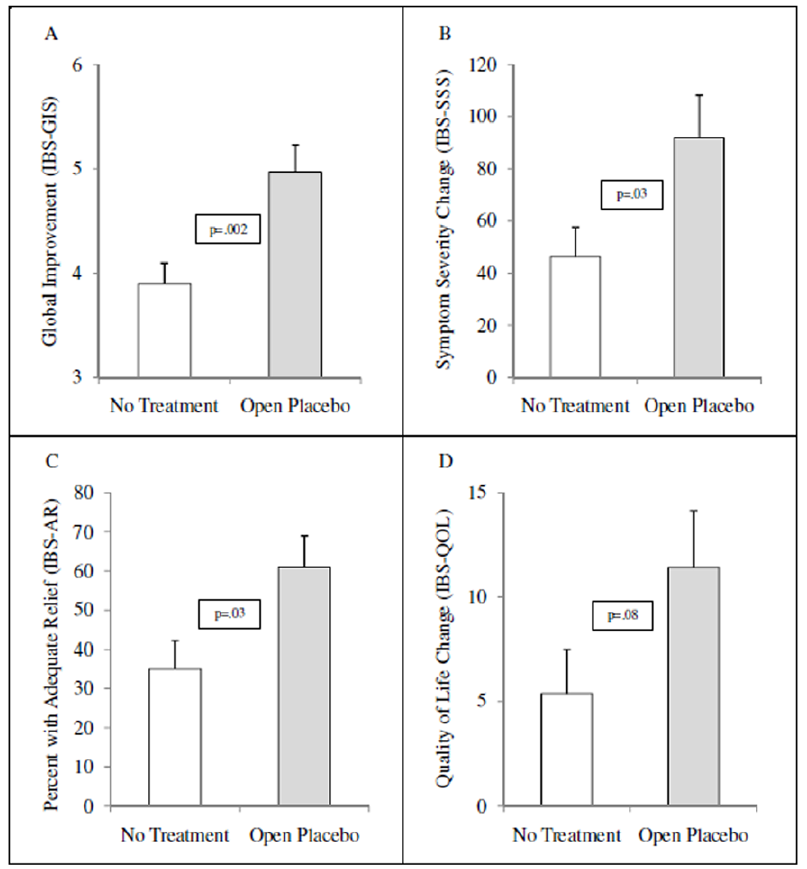
Figure 2. Outcomes at the 21-Day Endpoint by Treatment Group.